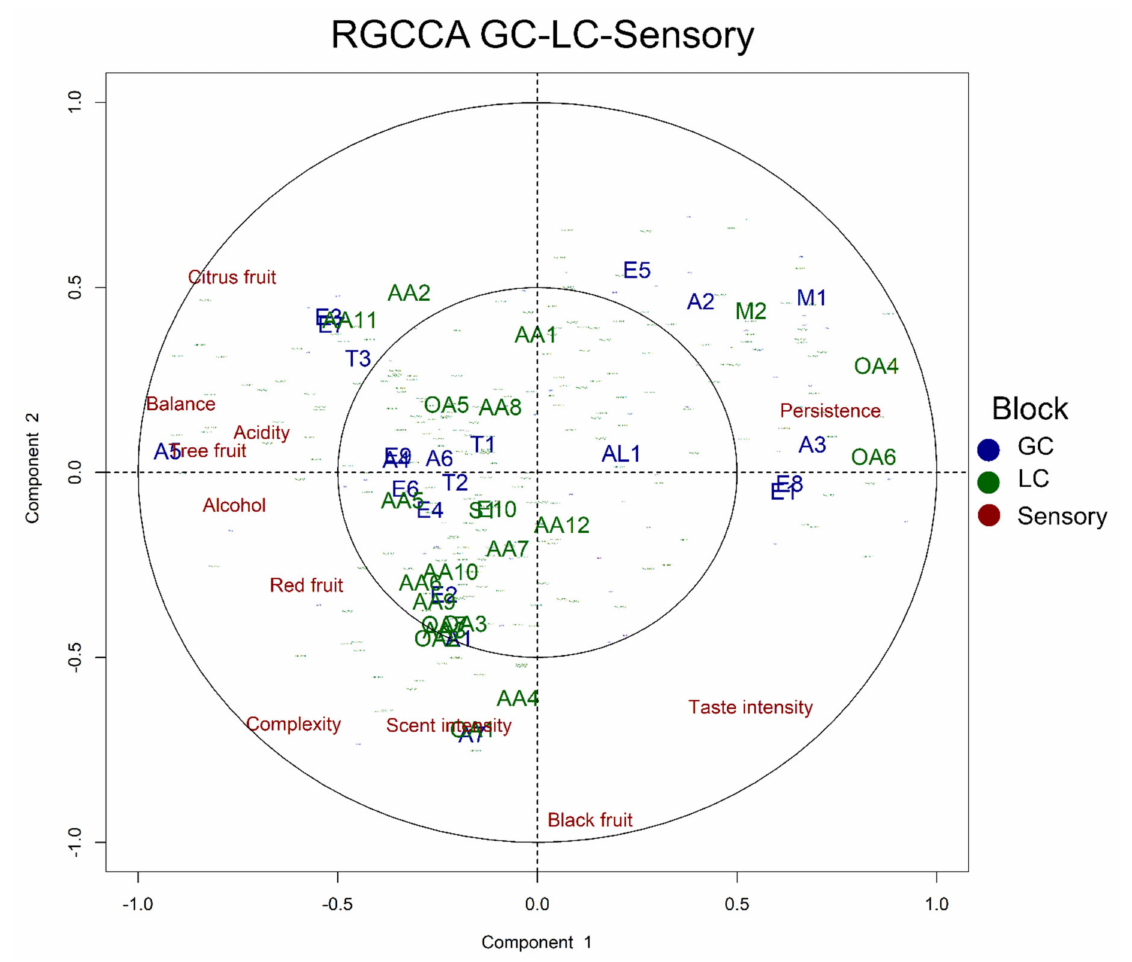
Figure 9. Circle correlation plot from the regularised generalised canonical correlation analysis (RGCCA) performed on the volatile, non-volatile and sensory data. A: alcohol, E: ester, M: miscellaneous, AA: amino acid, OA: organic